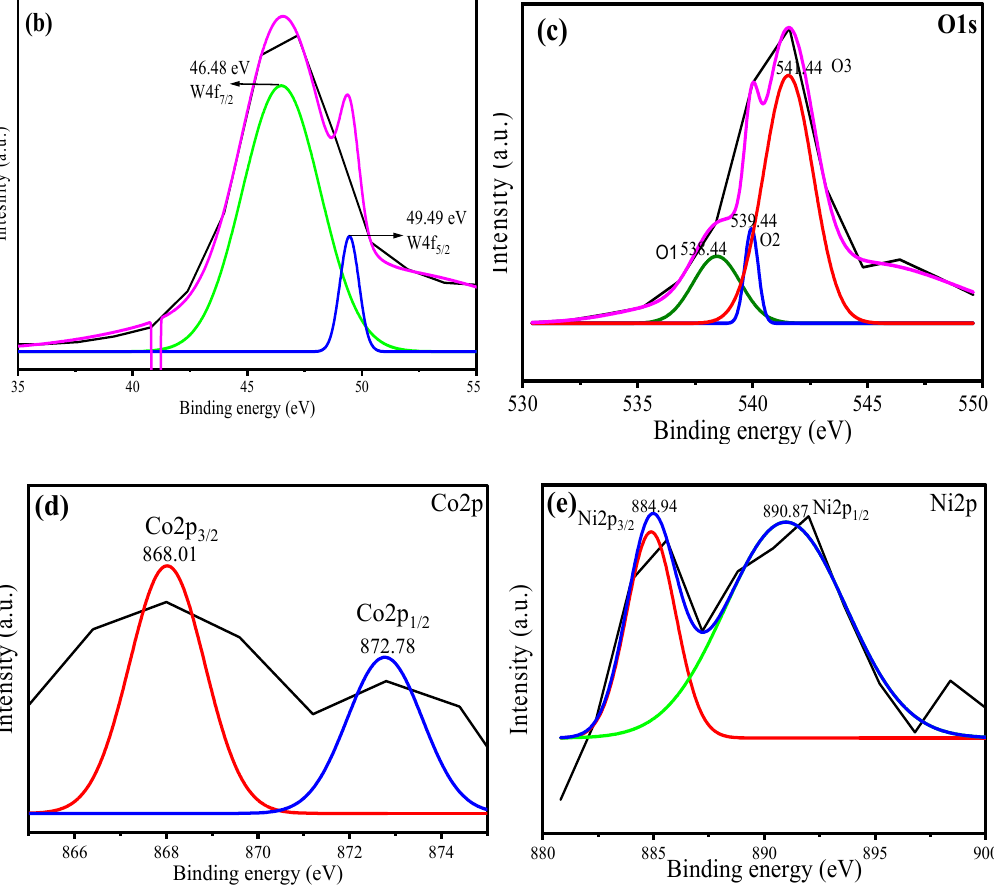
Figure 6. ( a ) XPS survey spectra of NiWO 4 /CoWO 4 NC deconvoluted XPS spectra for ( b ) W4f, ( c ) O1s, ( d ) Co2p, and ( e ) Ni2P.